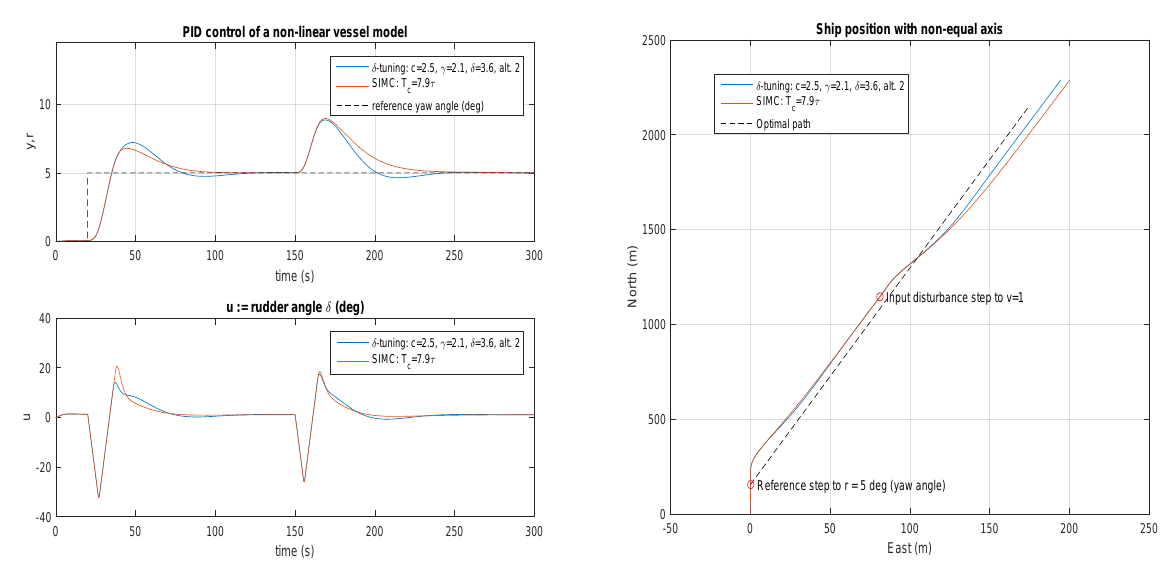
Figure 20: Shows PID control of the non-linear vessel model in Eq. (49). The PID controller is tuned using δ -tuning Alg. 2.1 and Eq. (27), with prescribed robustness δ = 3 . 6 and tune alternative 2. Reference step, r = 5 deg, at time = 20 s. Input disturbance step, v = 1, is introduced at time = 150